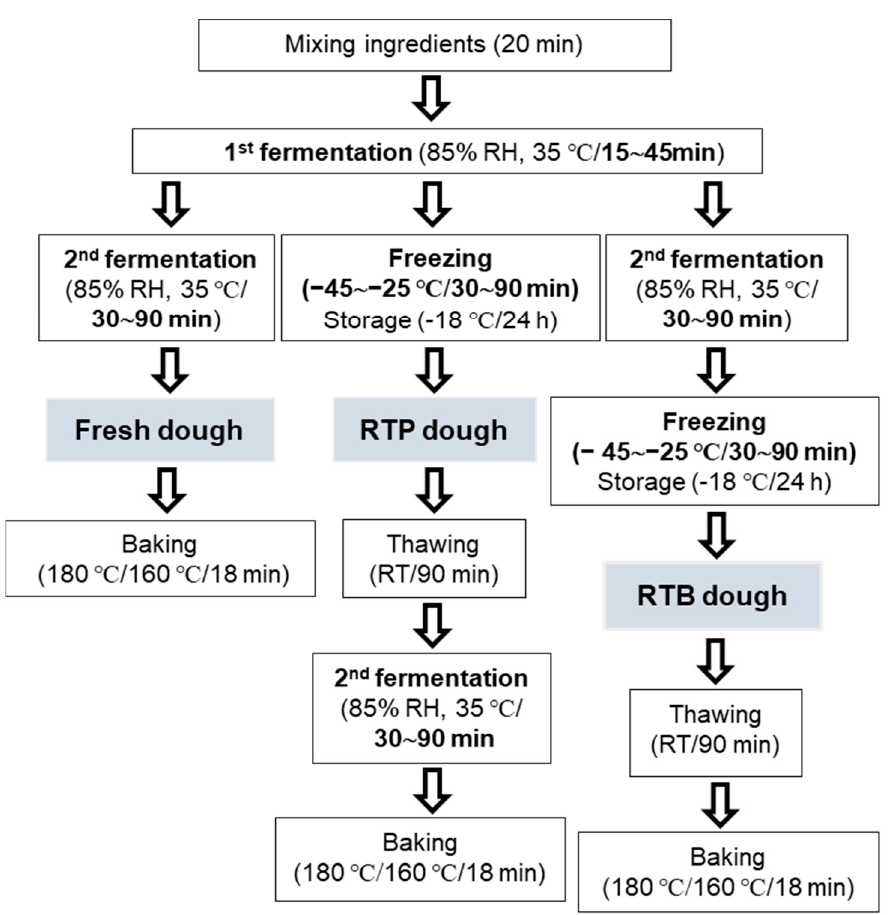
Figure 1. A diagram for preparing fresh, RTP, and RTB doughs and baked